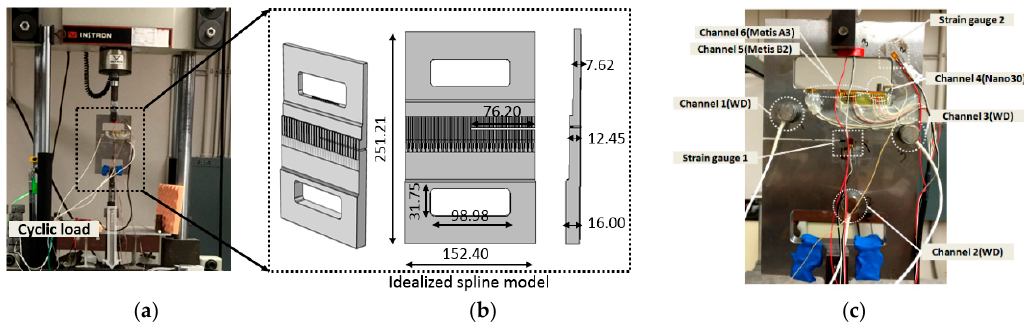
Figure 2. The UIC fatigue test, ( a ) the loading machine with the sample, ( b ) the planar spline sample and dimensions, and ( c ) the positions of AE sensors and strain gauge.